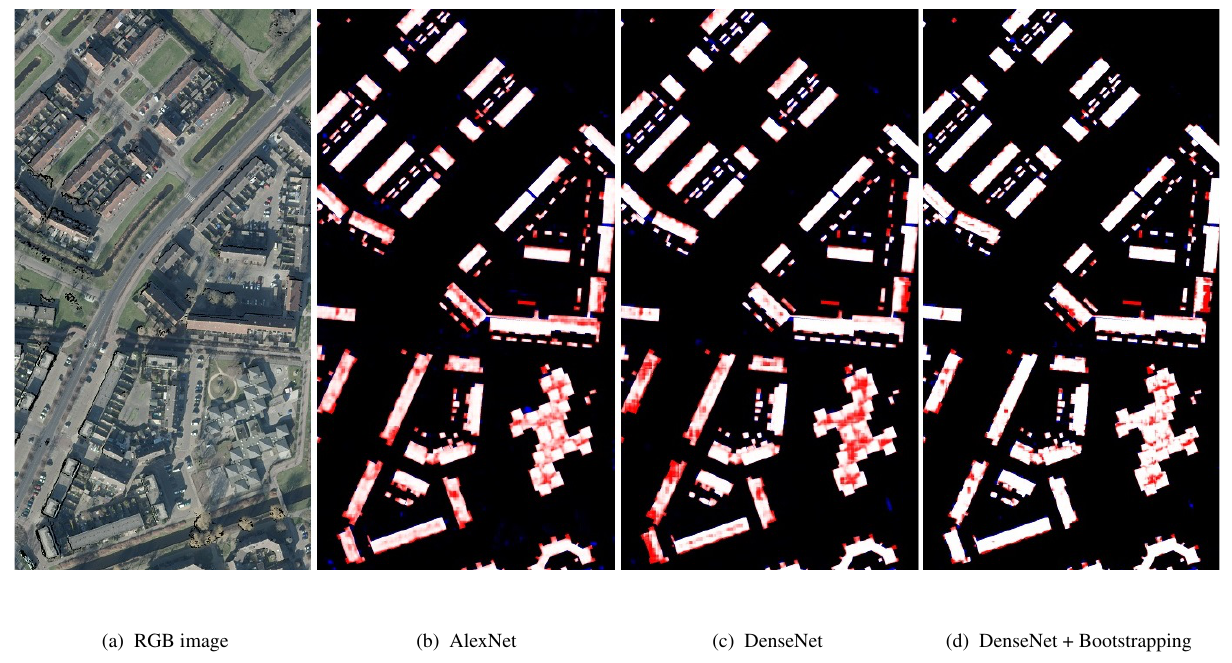
Figure 6. RGB image (area of 213 × 399 meters) and outputs from different networks. All networks are trained with RGB-D inputs (depth not shown). Large buildings segmented by AlexNet show better performance compared to DenseNet. However, more buildings are detected by DenseNet. After bootstrapping, DenseNet detects more buildings and improves the confidence of existing predictions.